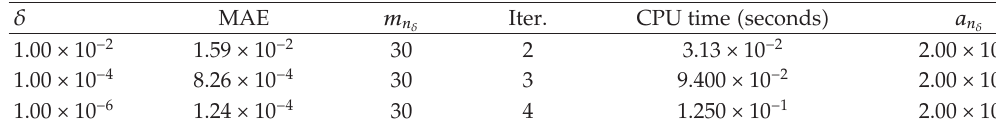
Table 4: Example